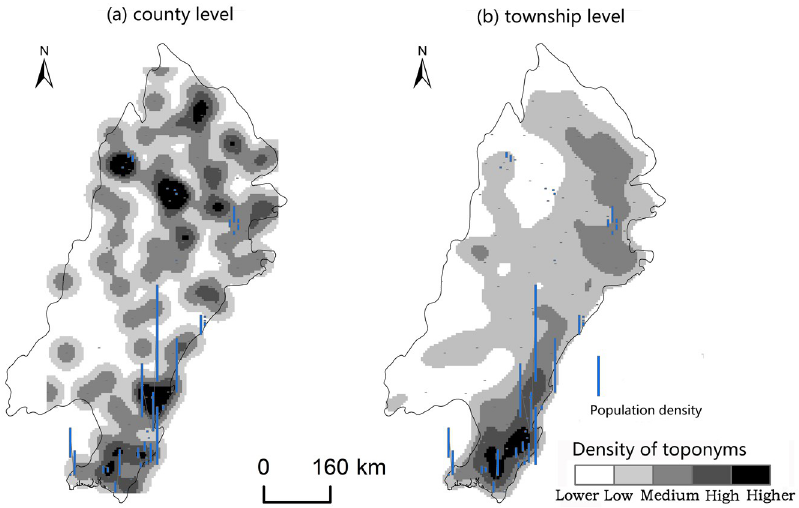
Fig 10. Spatial distribution of toponym density and county population density in the Northeast China Plain. Population data at the county level (Figs 9, 11, 13) were obtained from the 6 th Census of China (2010).